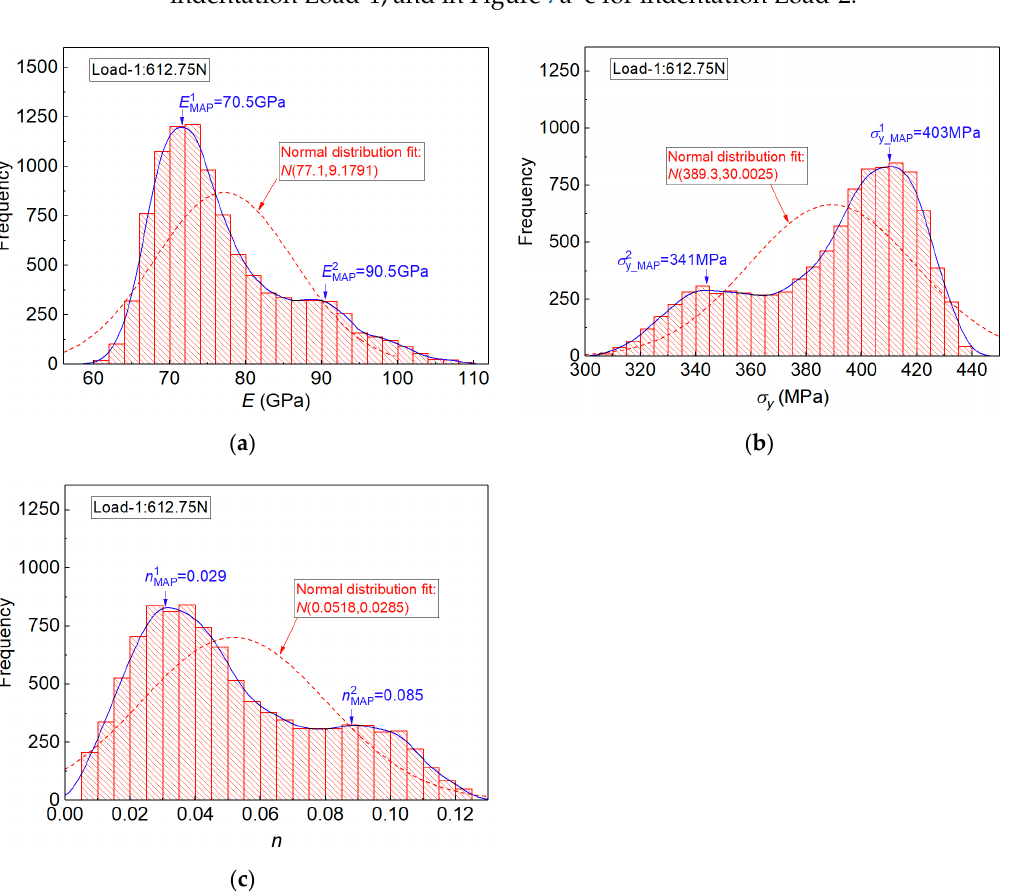
Figure 6. Posterior distribution results of the estimated elastoplastic properties from the established measuring method and experiment imprint snapshots under indentation Load-1: in ( a ) for E , in ( b ) for σ y and in ( c ) for n